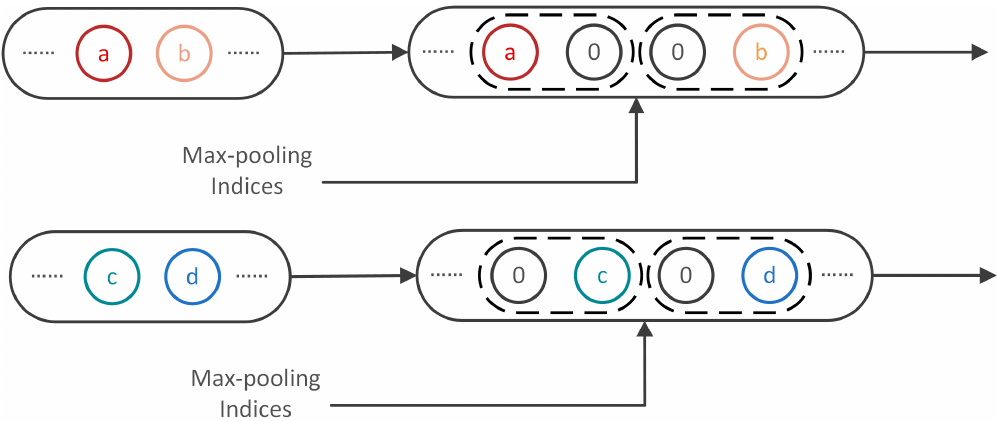
Figure 4. Max-pooling indices technique. a, b, c, d correspond to values in a feature map. D-net adopts the max-pooling indices storing the location information in max-pooling layer to upsample the feature map which further is sent to convolve with a trainable decoder filter